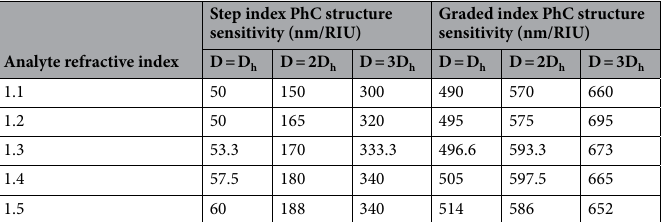
Table 2. Sensitivity comparison of SI-PhCR and EG-PhCR Structure with different defect layer thickness at a 0° incidence angle.